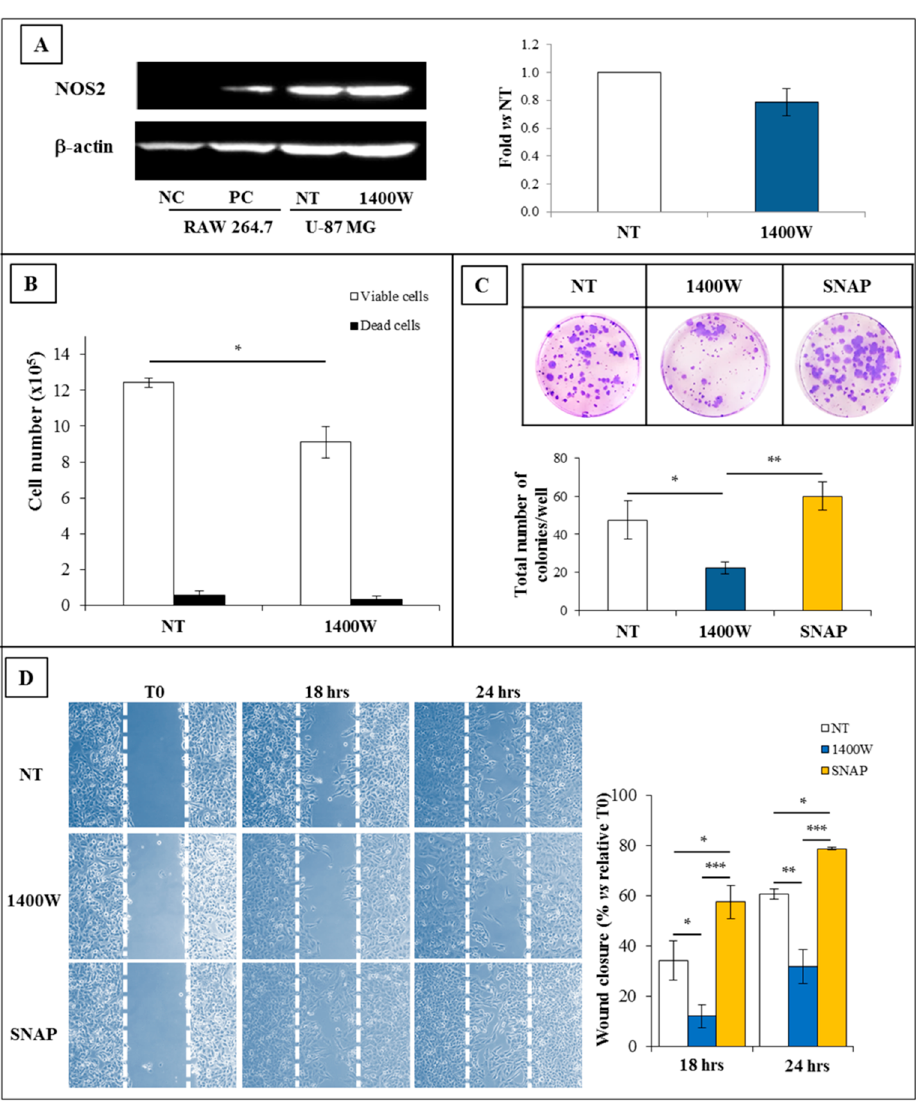
Figure 7. Expression and functional role of NOS2 in adherent human T98G cell line. ( A ) Representative Western blot of NOS2 and β -actin in T98G cells cultured in standard medium, (St-M) for 24 h. NC (negative control): Untreated RAW 264.7; PC (positive control): RAW 264.7 treated with LPS (1 μ g/mL) and IFN- γ (100 ng/mL) for 24 h. Results of quantification analysis of blots by densitometry expressed as fold vs. NT are reported in the histogram. The results from one experiment in duplicate are presented as mean ± SD. ( B ) Effect of NOS2 inhibitor 1400W (100 μ M) on T98G cell number (viable and dead cells) after 24 h of culture. The results from one experiment in duplicate are showed as mean ± SD. For comparison between two means, Student’s unpaired t -test was used (* p < 0.05). ( C ) Representative microscopic images of clonogenic assay of T98G cells not treated (NT) or treated daily with NOS2 activity inhibitor 1400W (100 μ M) for 10 days. The quantitative results of clonogenic assay are reported in the histogram and expressed as the total number of surviving colonies/well. Data represent the mean ± SD of one experiment in duplicate. For comparative analysis of groups of data, repeated two-way ANOVA measures followed by a Bonferroni post hoc test were used (* p < 0.05, ** p < 0.01). ( D ) Representative microscopy images of the scratch-wound healing assay captured at 0, 18 h, and 24 h. Scratched T98G monolayers were incubated without (NT) or with NOS2 inhibitor 1400W (100 μ M) or NO-donor SNAP (100 μ M) for the indicated times after injury (10× magnification). The wound-closure rate was calculated as described and expressed as % closure vs. relative to T0 at 18 h and 24 h. Data are expressed as the mean ± SD of one experiment in duplicate. For the comparative analysis of groups of data, repeated measures two-way ANOVA followed by a Bonferroni post hoc test were used (* p < 0.05, ** p < 0.01, *** p < 0.001).